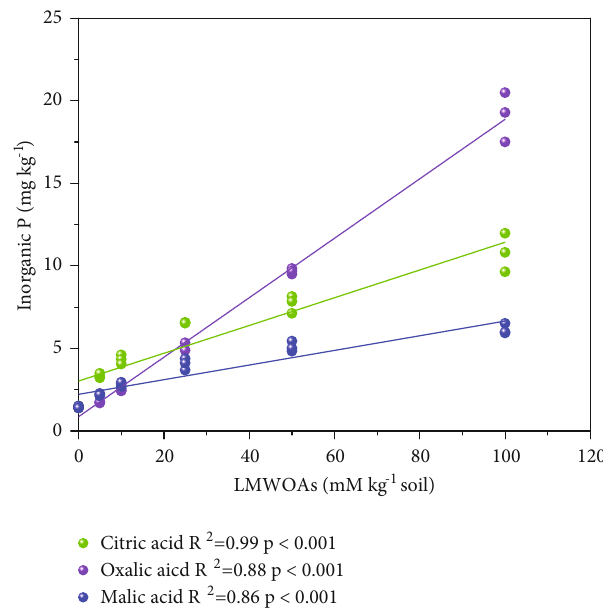
Figure 2: The release of inorganic P after the addition of di ff erent concentrations of low molecular weight organic acids (oxalic acid, citric acid, and malic acid) for one